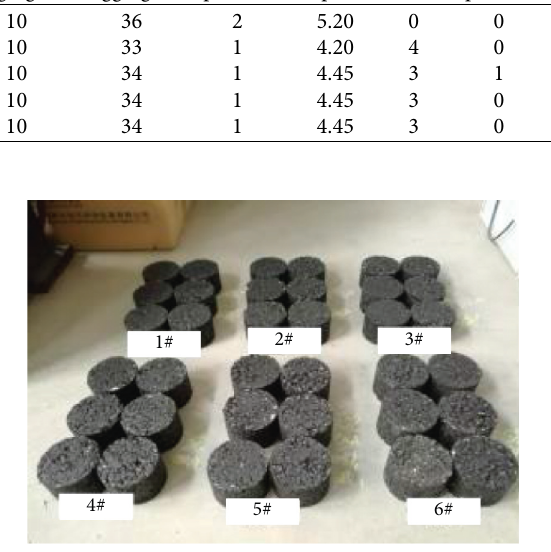
Figure 2: Standard test specimen for Marshall test. Table 3: Physical performance index of Marshall